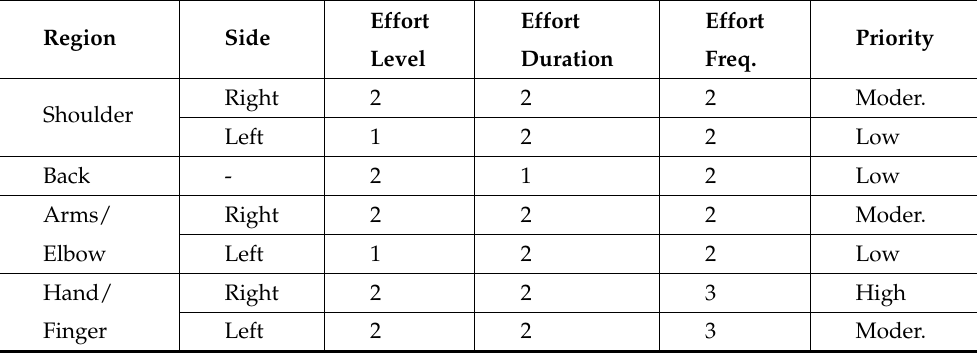
Table 4. Suzanne Rodgers analysis before automation